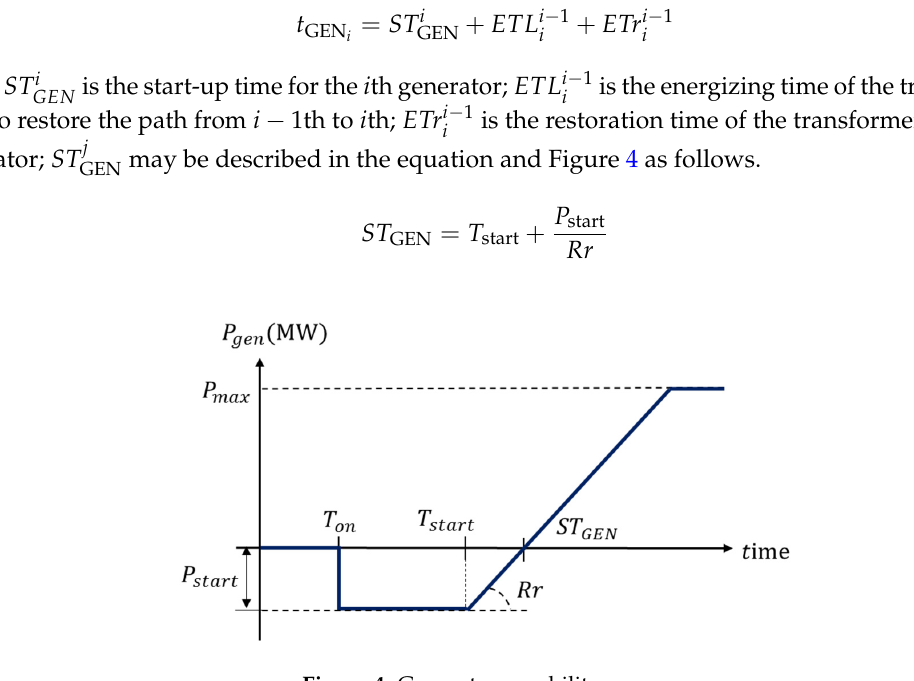
Figure 4. Generator capability curve.